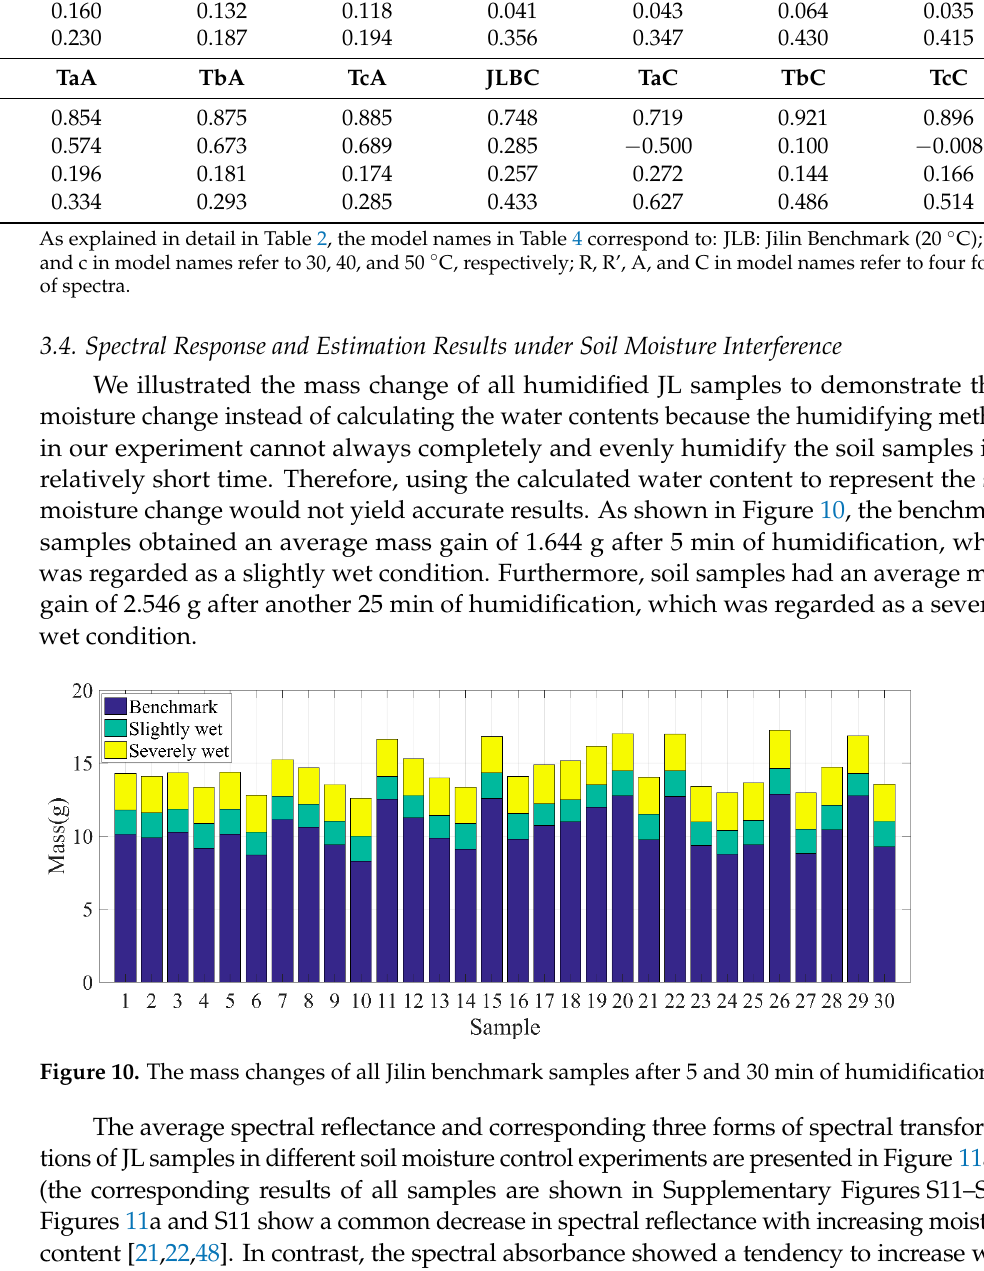
Table 4. Estimation accuracy of PLS models in the soil temperature control experiment.